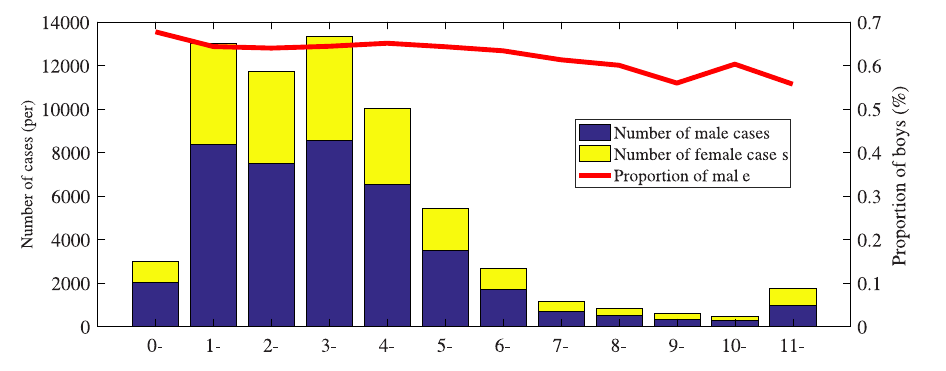
Fig 2. Gender distribution of the confirmed cases for different ages.